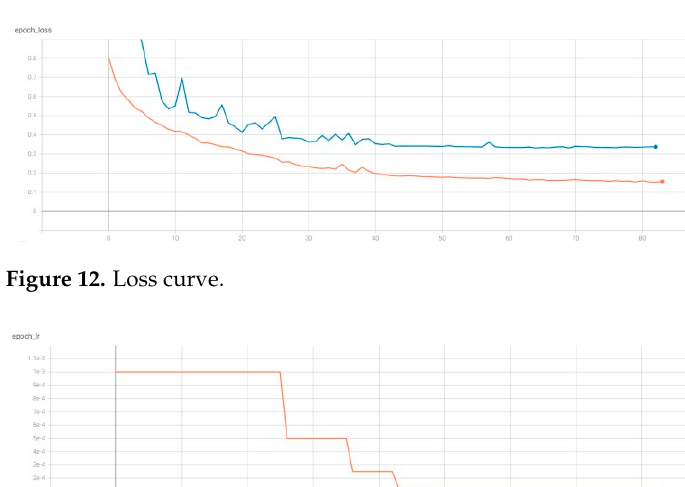
Figure 11. IoU learning curve.